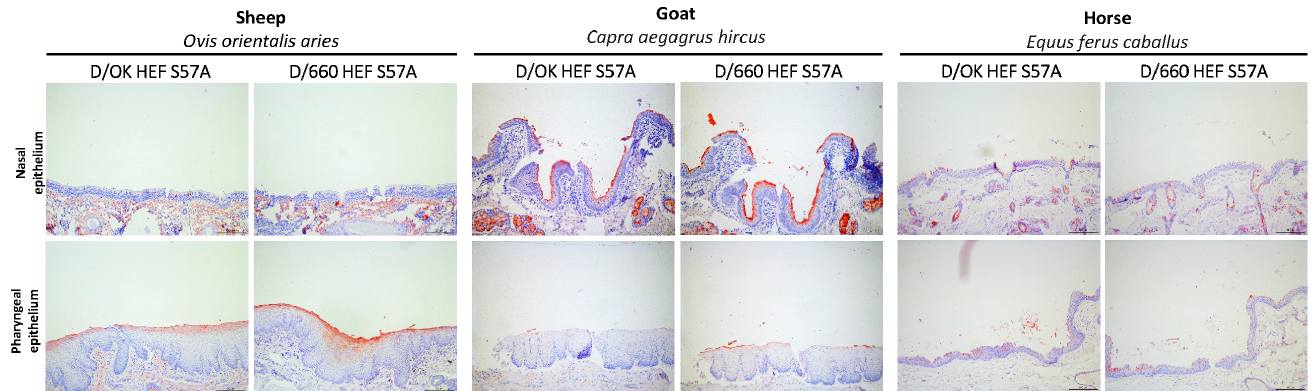
Figure 5. Protein histochemical staining of tissue micro-arrays containing sheep (2 on array), goat (4 on array), and horse (5 on array) respiratory tissues with D/OK and D/660 HEF S57A proteins at 50 µg/mL, only the nasal and pharyngeal epithelium is shown, see the Supplementary Figure S1 for the protein histochemical staining of the respiratory tract of sheep goat and horse. Scale bars are 20 µm. Technical repeats were performed 3 times on each microarray. See Supplementary Tables S3–S5 for content and arrangement of each microarray.